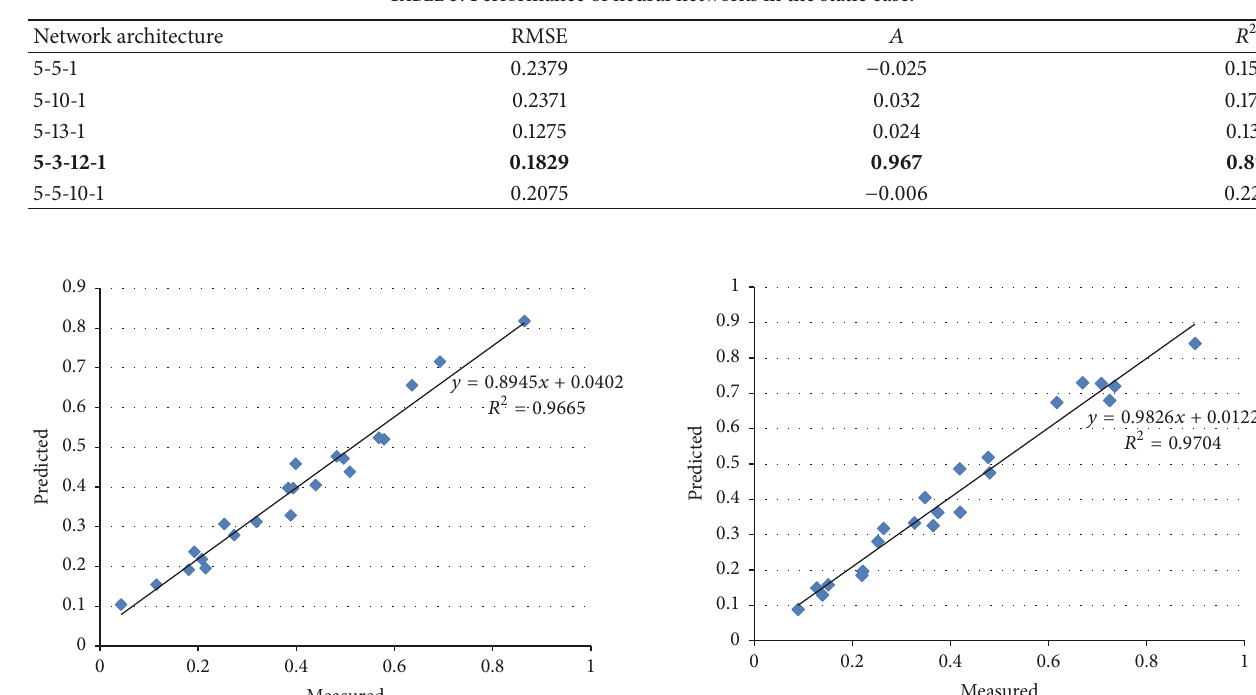
Table 3: Performance of neural networks in the static case.